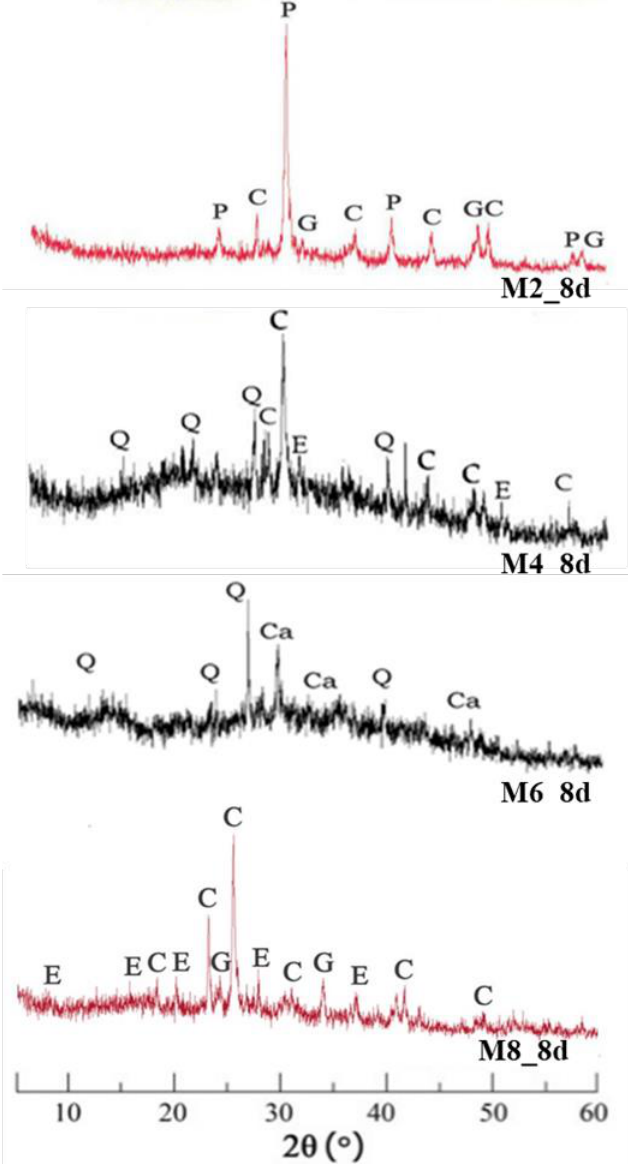
Figure 4. XRD patterns of SAR paste at 8 days. (P): portlandite; (G): gypsum; (C): C–S–H; (E): ettringite; (Ca): CaCO 3 ; (Q): SiO 2 .